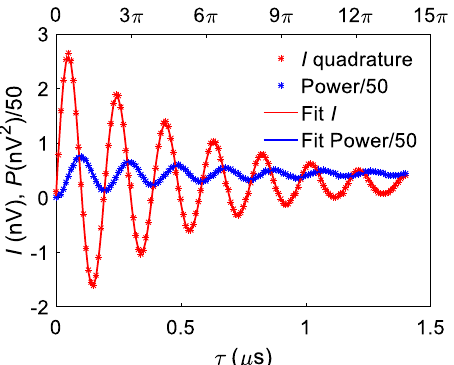
Fig. 2 Quadrature and power oscillations of emitted radiation from the driven qubit vs pulse length τ . Red stars represent the measured I quadrature amplitude, while blue stars correspond to the emitted power 〈 P 〉 = 〈 ( I 2 + Q 2 ) 〉 . Both traces are fi tted to a sinusoid function with an exponential-decay envelope, simulta- neously. The extracted decay rate is 2 π * 629 kHz. Moreover, the phase of the two fi tting curves is offset by π /2, which rules out a coherent state and provides evidence for single-photon emission. The top axis indicates the angle of the qubit-state rotation on the Bloch sphere. The external fl ux is Φ = 0.